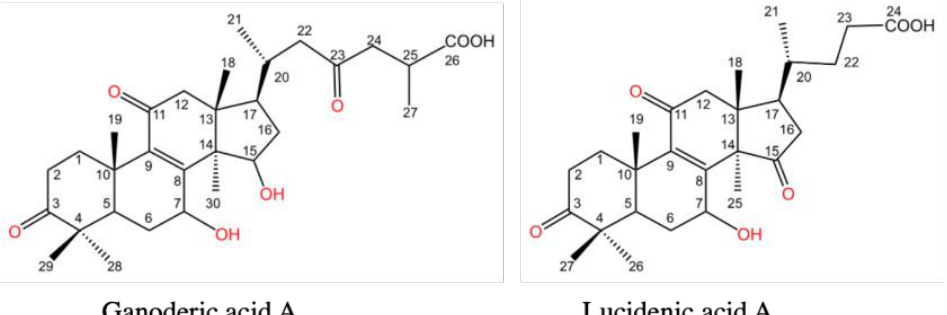
Figure 1. Chemical structures of ganoderic acid A and lucidenic acid A.